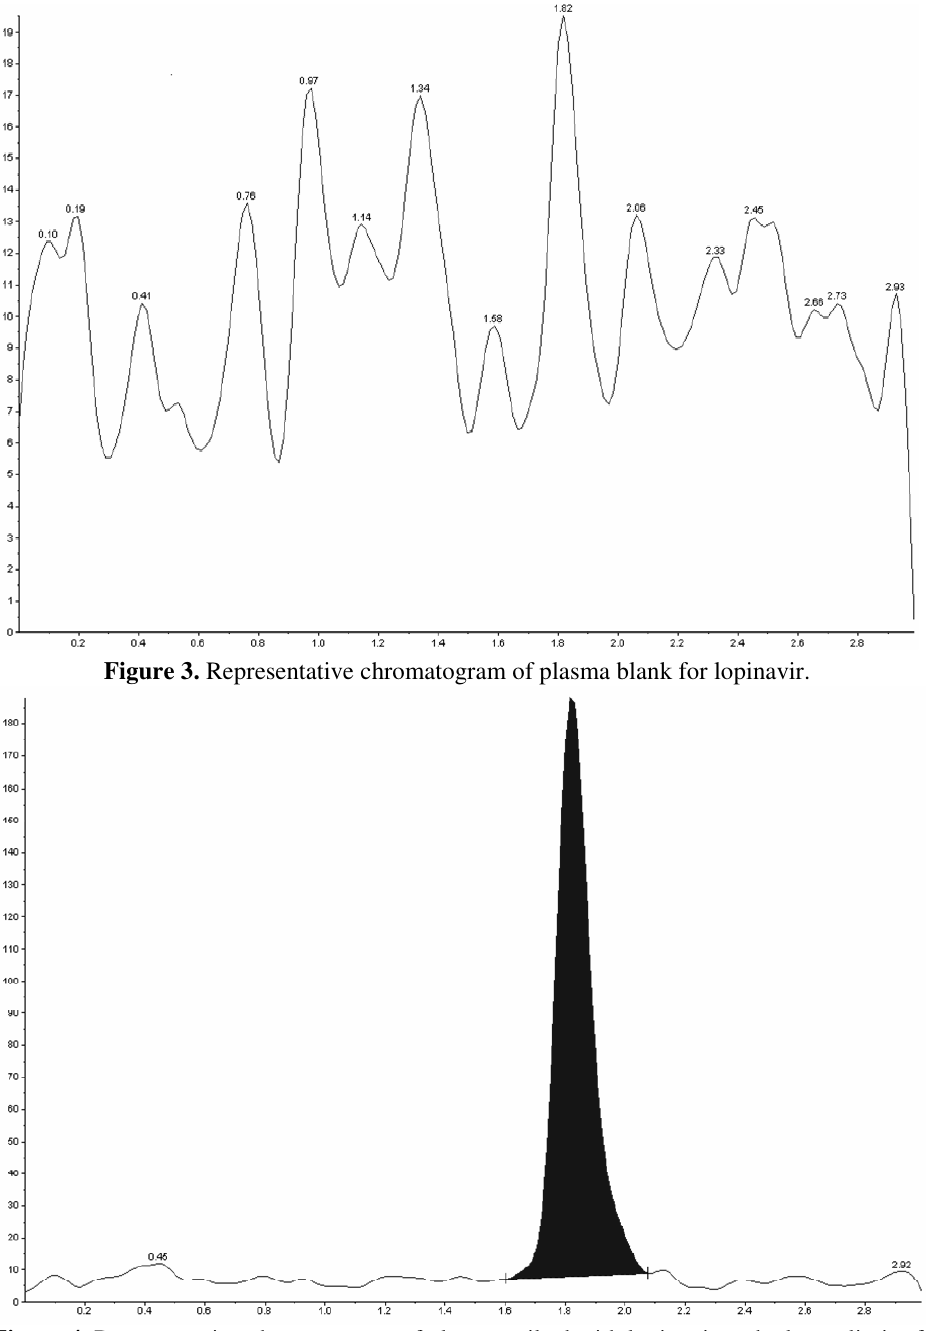
Figure 4. Representative chromatogram of plasma spiked with lopinavir at the lower limit of quantification (50.0 ng mL -1